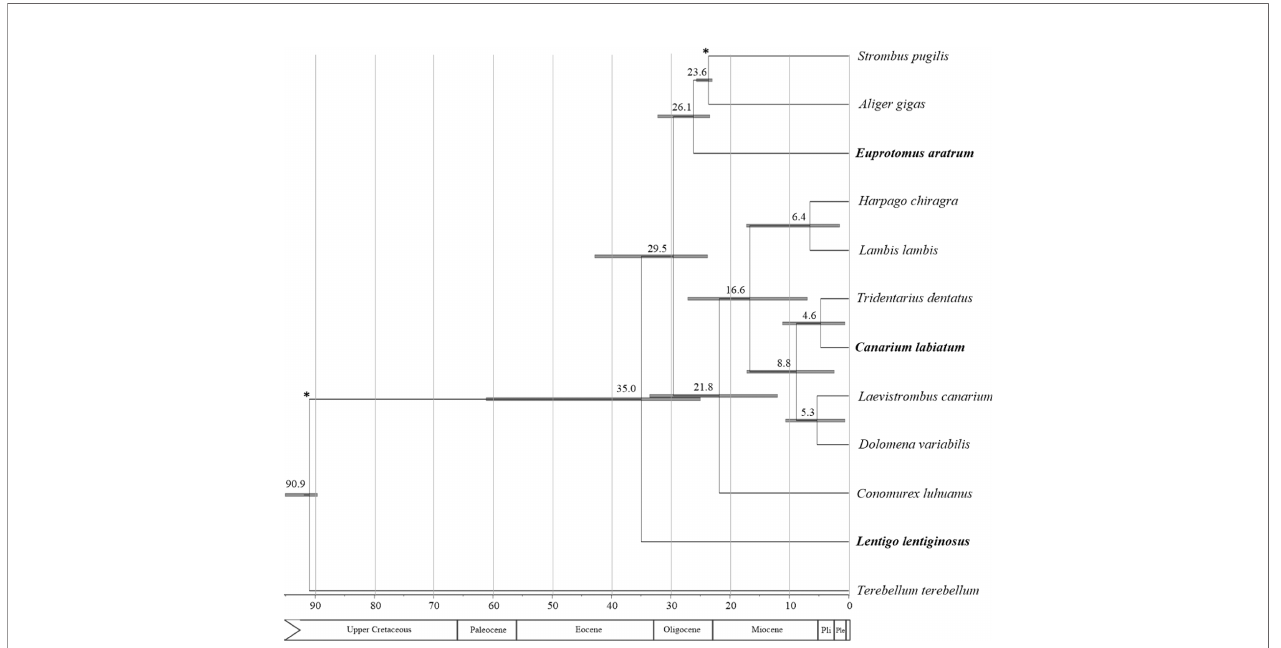
FIGURE 6 | Divergences time estimations for the Strombidae using Bayesian relaxed dating methods (BEAST) based on nucleotide sequences of 13 mitochondrial protein-coding genes (PCGs) and 2 ribosomal RNA (rRNA) genes: dates (and credibility intervals) are in millions of years, and horizontal bars represent 95% credibility intervals of relevant nodes. Calibration constraints are indicated with an asterisk on the corresponding